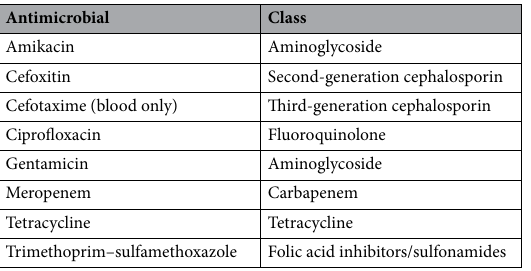
Table 1. Antimicrobials used for AST by disc diffusion for neonatal and environmental